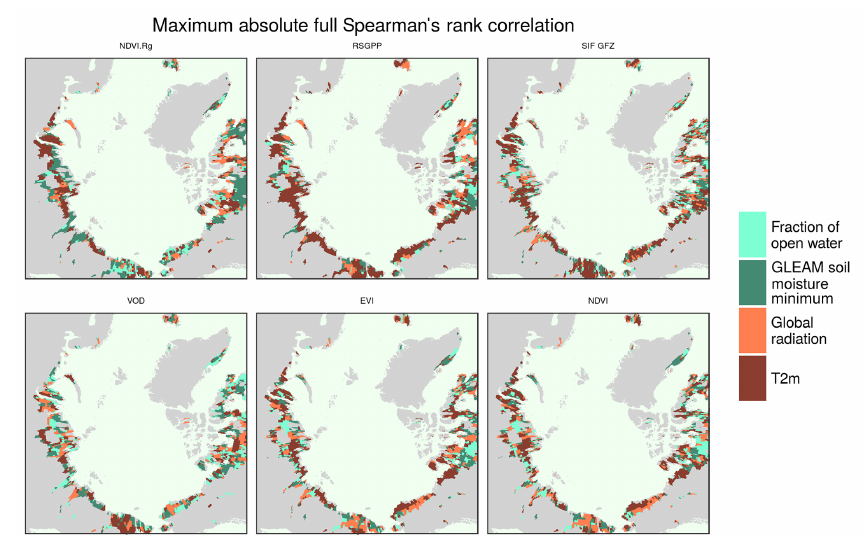
Figure A6. Spearman’s rank correlation between the peak DOY of the vegetation proxies across years and the peak DOY of environmental variables in spatial moving windows of 1.5 ◦ (9 spatial pixels times 10 years at most, correlated only if more than 20 data points available). Plotted here is the variable with the highest absolute correlation without filter for statistical significance. Full correlations have been calculated (no partial